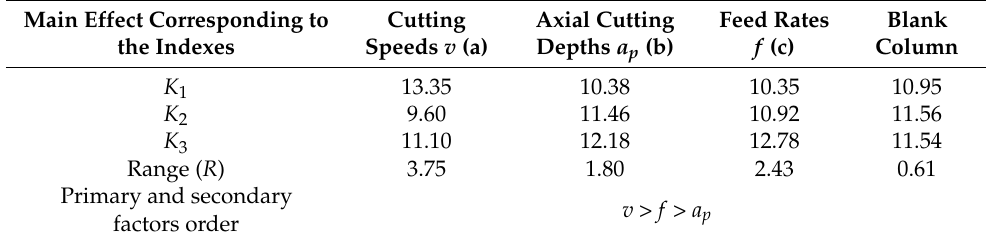
Table 6. S q range calculation of orthogonal